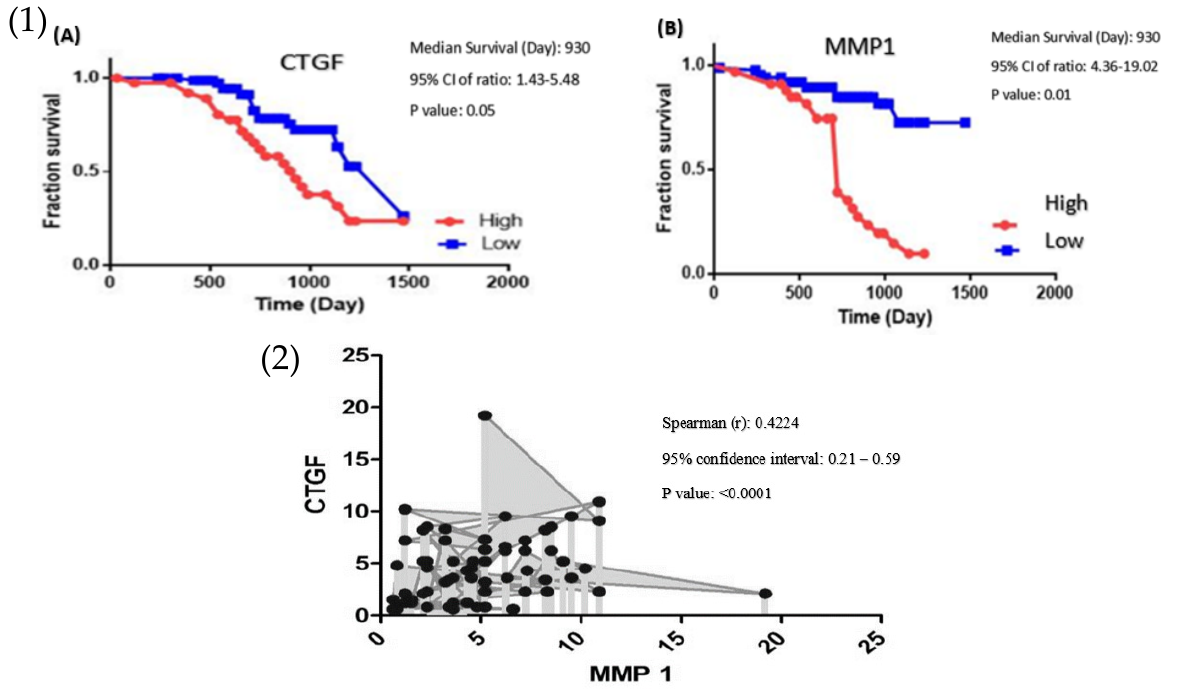
Figure 3. (1) Log Rank Test demonstrate the association between survival rate and the expression level of ( A ) CTGF and ( B ) MMP-1 in patients with colon cancer. (2) Association between the CTGF and MMP-1 expression level (Spearman’s rank test, r = 0.4224, p < 0.0001, n = 81). * r = Spearman’s rank, n = Number of XY Pairs.